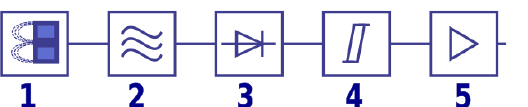
Figure 1. Block diagram of an inductive sensor consisting of 1–Sensor Field; 2–electronic oscillator; 3–Demodulator; 4–Flip-Flop; 5–Output [18].